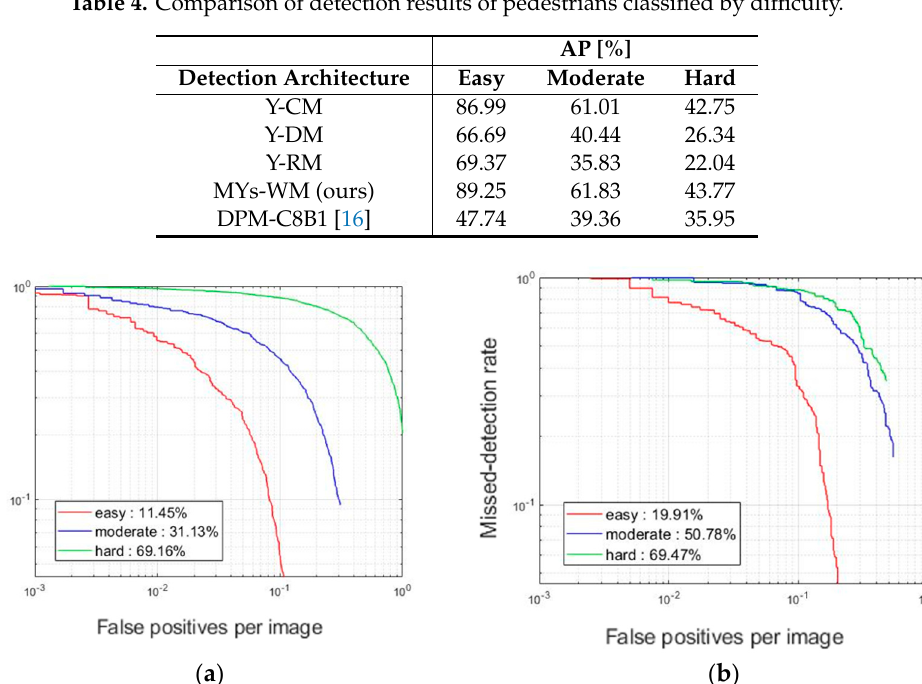
Table 4. Comparison of detection results of pedestrians classified by difficulty.